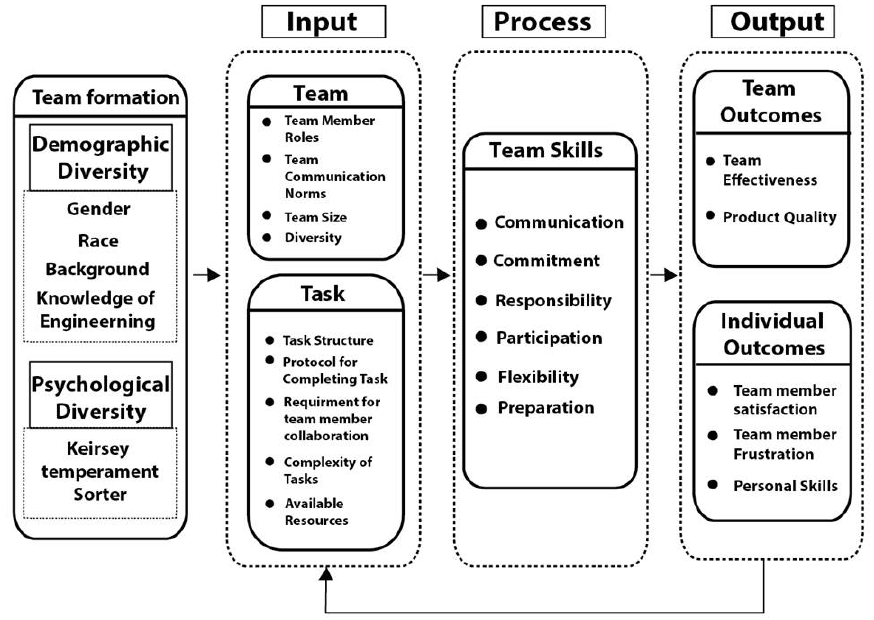
Fig. 1. Figure 1. Diverse multidisciplinary team formation